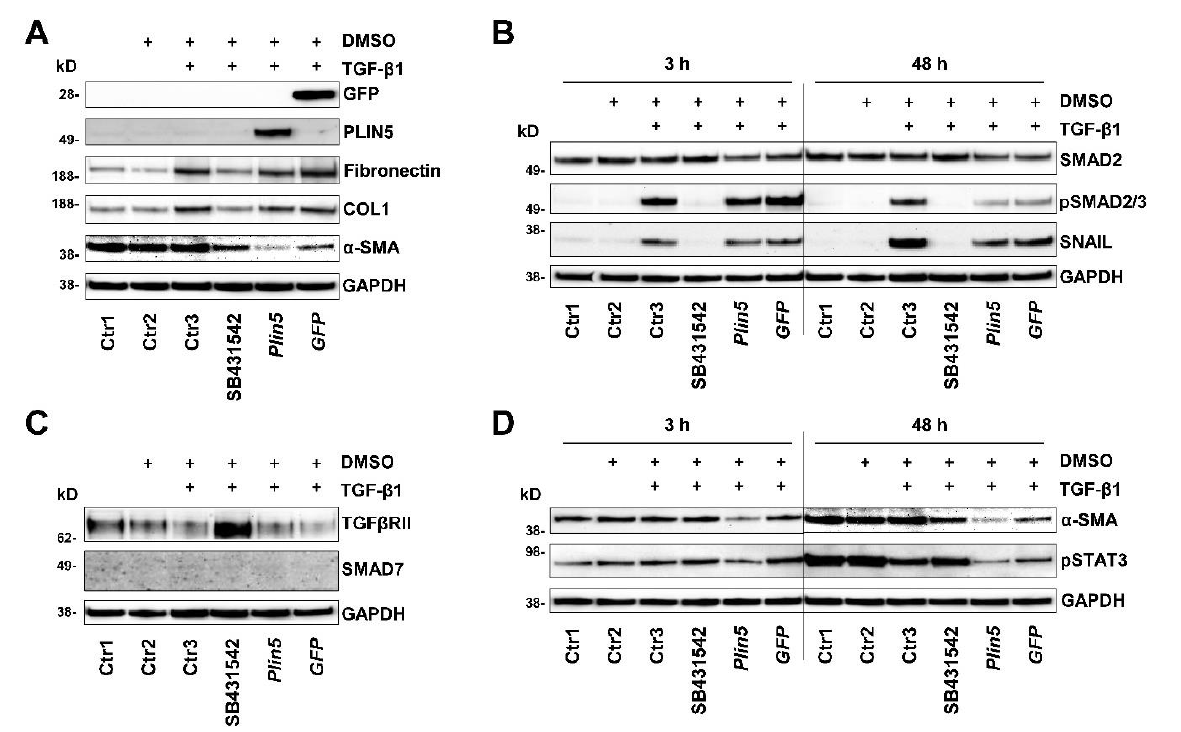
Figure 5. PLIN5 overexpression protects against TGF- β1 -mediated STAT3 phosphorylation. Western blot analysis of Plin5 transfected LX-2 cells compared to TGF- β receptor inhibitor treated cells and control conditions. Cells were stimulated with TGF- β 1 (2.5 ng/mL) for indicated time intervals. GFP transfection served as a negative control. As a further control, cells that were treated with DMSO serving as the inhibitor carrier medium were analyzed. In addition, three further controls, one untreated (Ctr1), one only exposed to DMSO (Ctr2), and one stimulated and exposed to DMSO (Ctr3) were analysed. ( A ) Analysis of expression of extracellular matrix proteins, GFP, and PLIN5 under these conditions stimulated for 48 h. ( B ) Analysis of SMAD2/3 activation and downstream transcription factor SNAIL. ( C ) Alterations in the expression of the TGFβRII and the SMAD7 after 48 h stimulation are shown. ( D ) Phosphorylation of STAT3 at Tyr705 and expression of α -SMA after TGF- β1 stimulation for 3 h or 48 h. All experiments were done in triplicate.